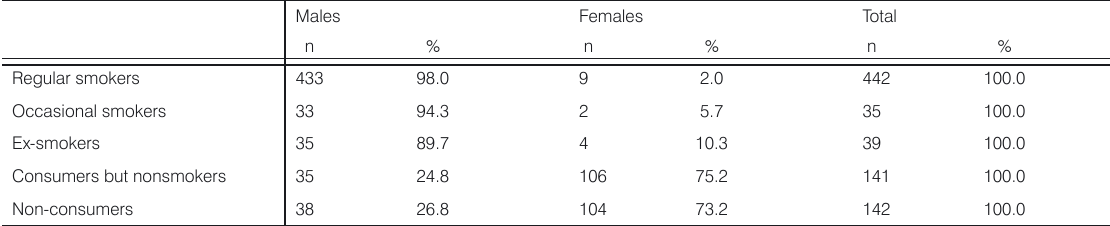
Table 2. Detailed tobacco consumption history of